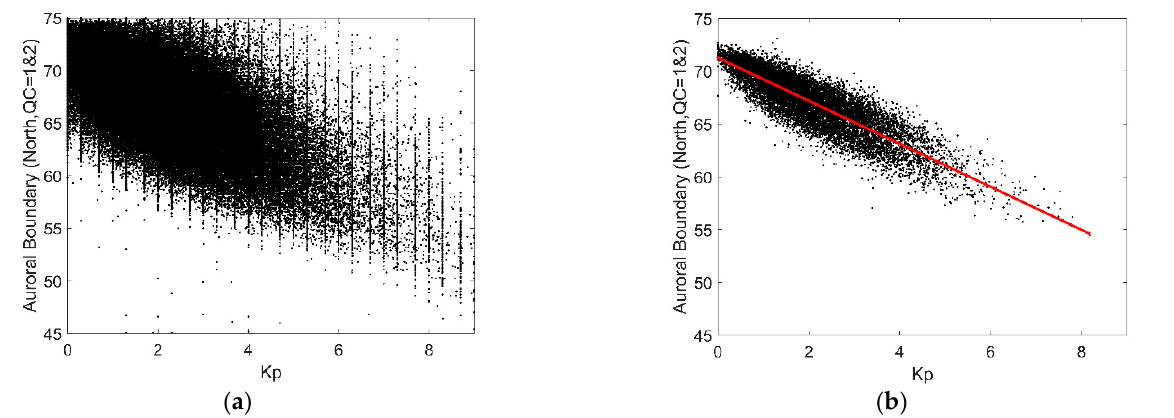
Figure 3. AB in degrees (°) vs. Kp for the northern hemisphere for data with QC = 1 & 2 during the period 1983–2016 considering the original data ( a ) and the daily means ( b ). The linear fit for the daily means ( b ) is in red.